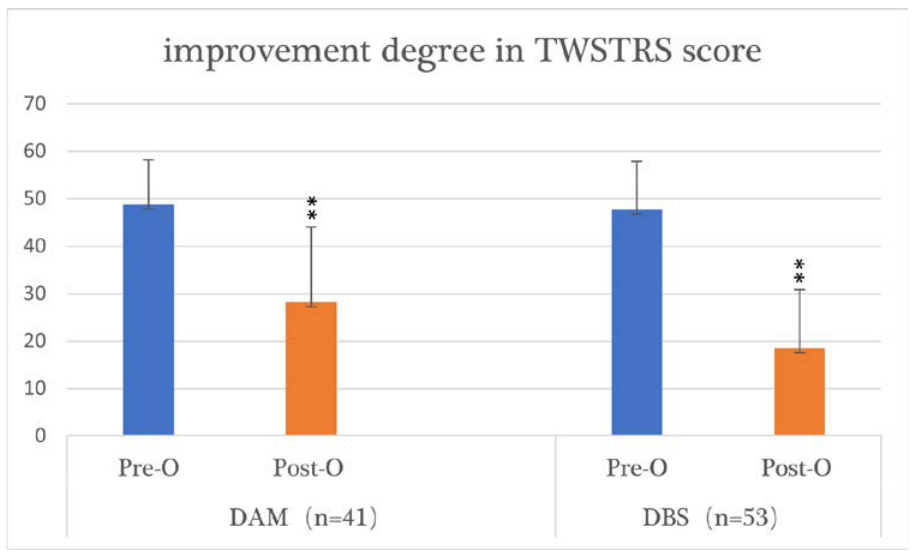
Figure 2. The improvement in TWSTRS scores in the DAM group and DBS group. TWSTRS: the